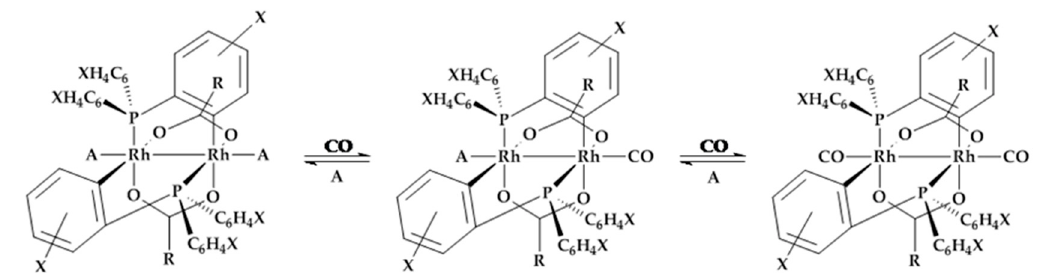
Figure 3. Reaction scheme of the rhodium complex with CO.